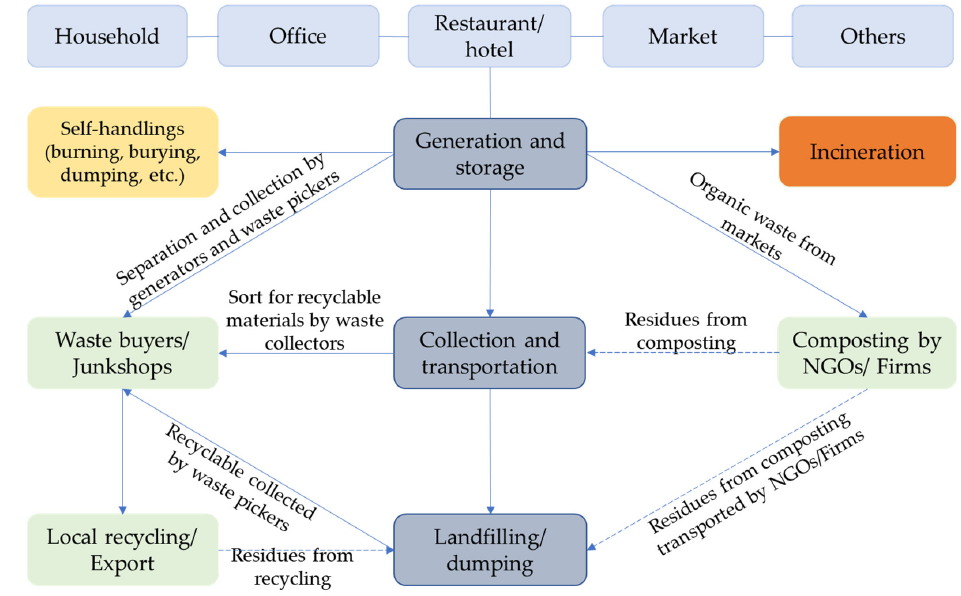
Figure 3. Diagram of MSW management stream in Cambodia.